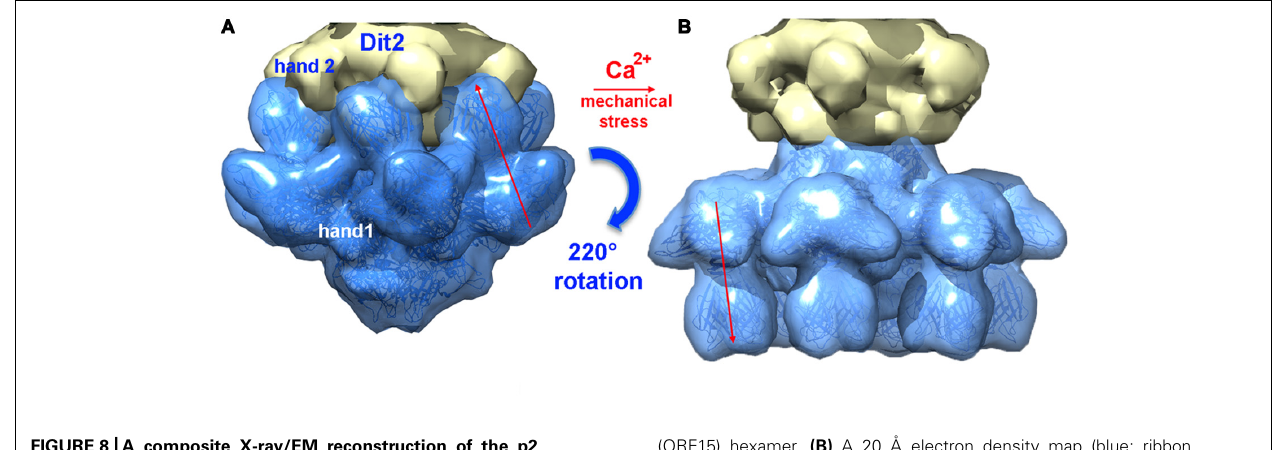
(ORF15) hexamer. (B) A 20 Å electron density map (blue; ribbon structure inside) of the activated form of the p2 baseplate crystal structure was calculated and appended to the upper Dit EM map (yellow). Figure adapted from Bebeacua etal. (2013b). Copyright © American Society for Microbiology.